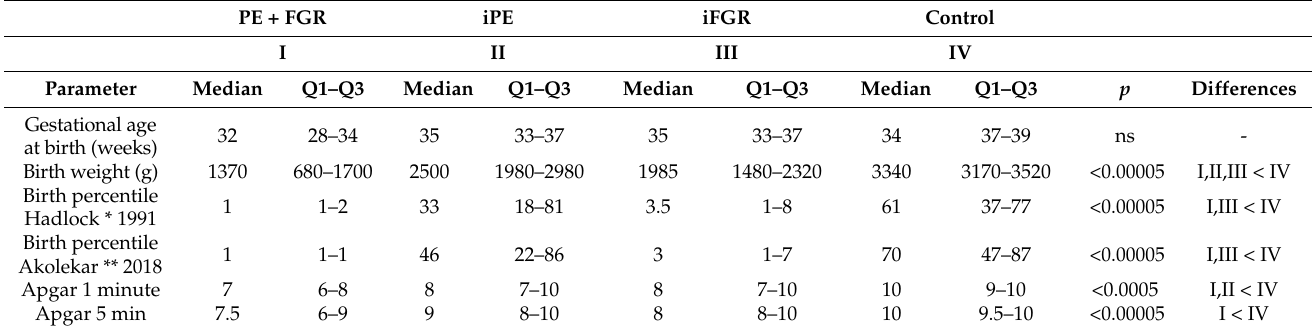
Table 4. Characteristics and statistical analysis of neonatal outcomes of the study groups (based on results of the Kruskal-Wallis test and analysis of variance ANOVA with a post hoc RIR Tukey